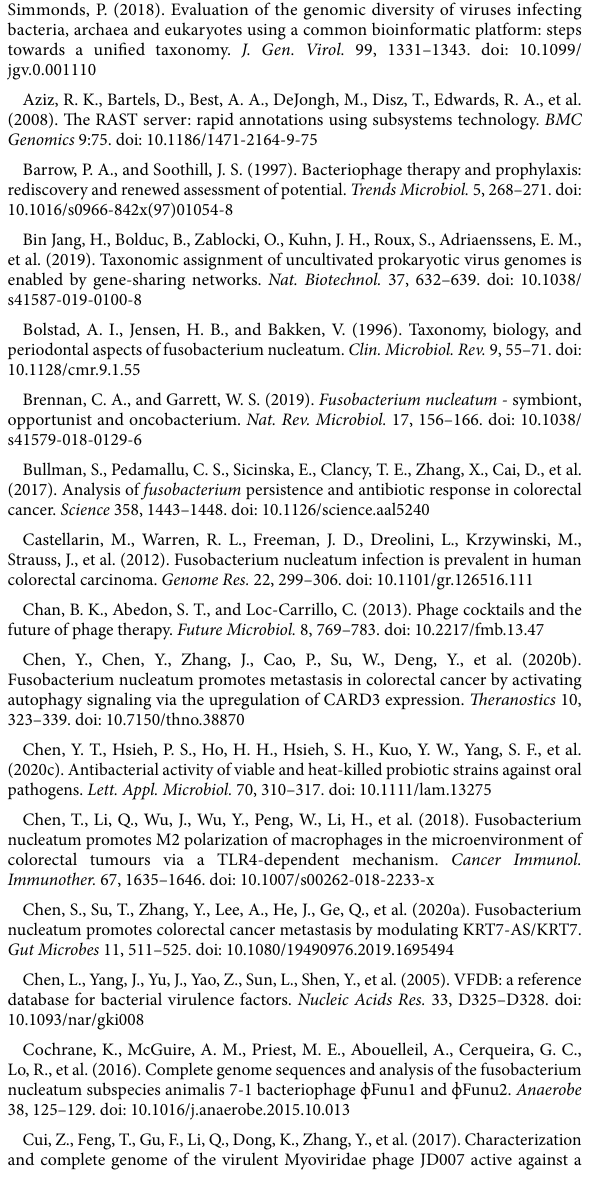
The dark blue color represents the existence of protein. JD-Fnp1 ~ JD- Fnp5 are new F. nucleatum bacteriophages discovered in this study, which are shown in red. FNU1 and φ Funu1 are reported F. nucleatum phages with whole-genome sequence data and are shown in blue. Other bacteriophages are displayed according to their serial numbers in IMG/ VR v3. SUPPLEMENTARY FIGURE S3 Conserved domains comparison of JD-Fnp1 ~ JD-Fnp5, FNU1, φ Funu1, and metagenomics assemblies from IMG/VR v3. The heatmap was